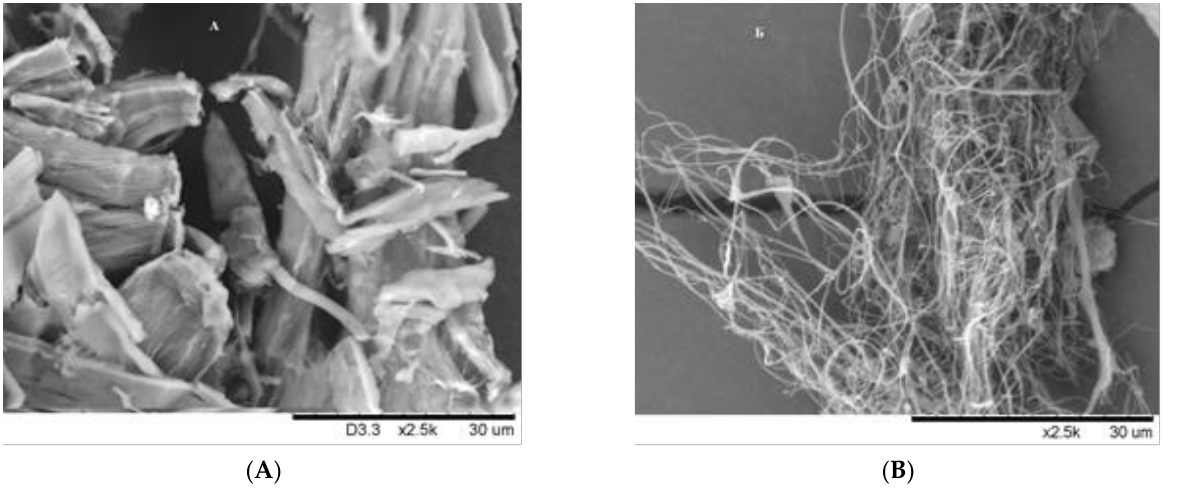
Figure 8. Micrographs of cellulose samples: ( A ) MCC; ( B ) MFC.